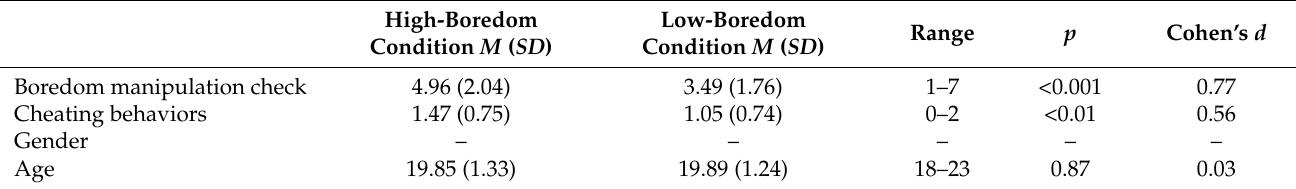
Table 1. Demographic characteristics of participants.